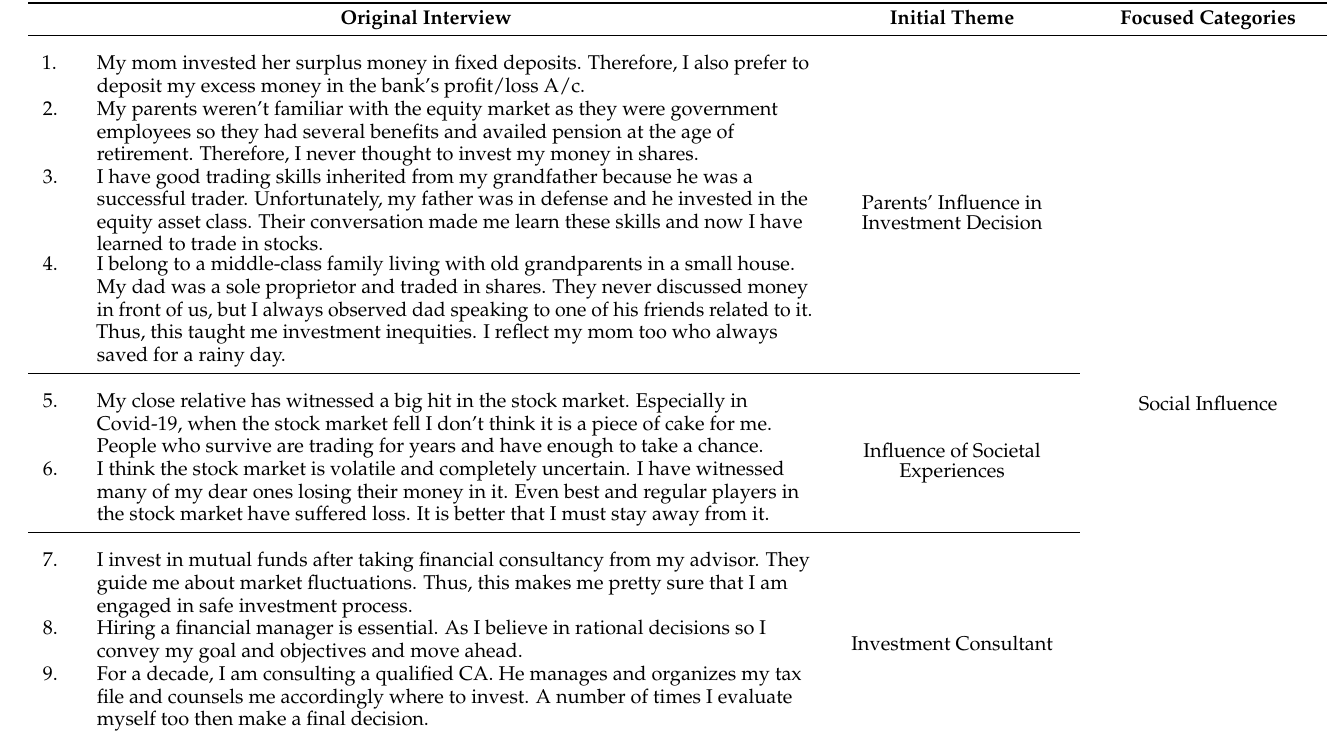
Figure 1. Process of Manual Coding Involved—(Source Corbin and Strauss 1990). The responses were recognized as the initial themes, then connections between several codes were cohesively employed to derive the focused categories. As illustrated in Table 2. To estimate the validity of the coded data, it was proved with the prevailing literature and associated studies. This procedure was recapped after every interview that eventually directed towards the next interview and finally refinement for selective coding. Table 2. Coding Identified on Common Subject Matter.